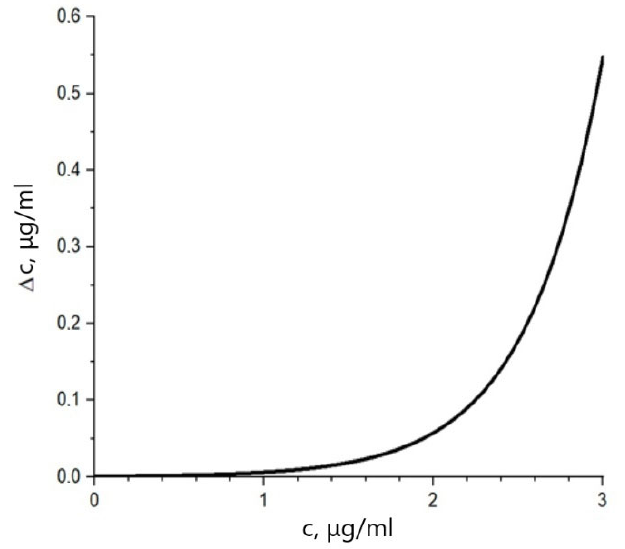
Figure 4. Standard deviation of measured dye concentration depending on the real dye concentration in tissue.